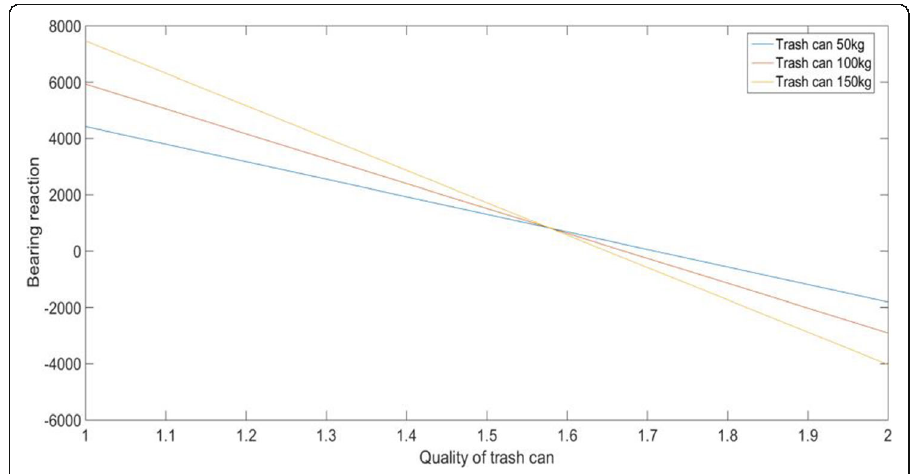
Fig. 5 Comparison of front and rear reaction forces at the gripper interface of the manipulator